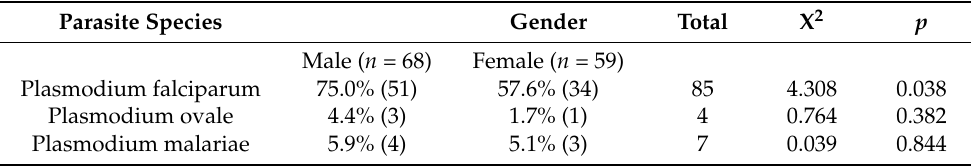
Table 4. Association of the prevalence of asymptomatic malaria species with gender. Parasite Species